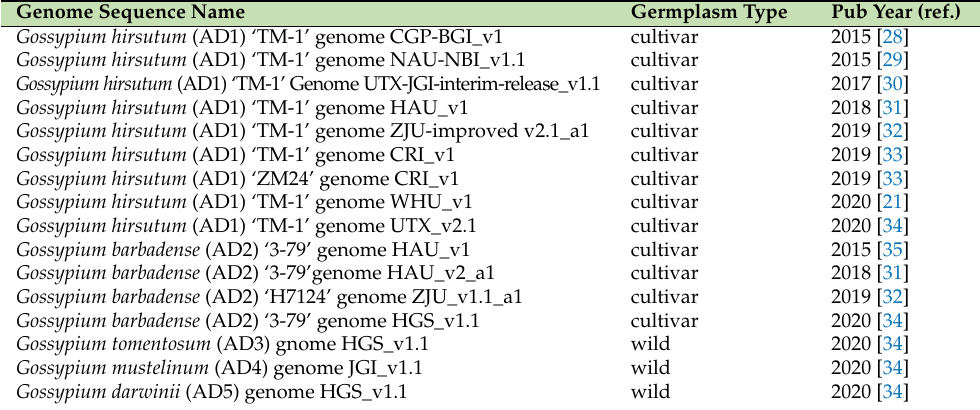
Table 3. List of 16 tetraploid genome sequences available in CottonGen (by 31 August